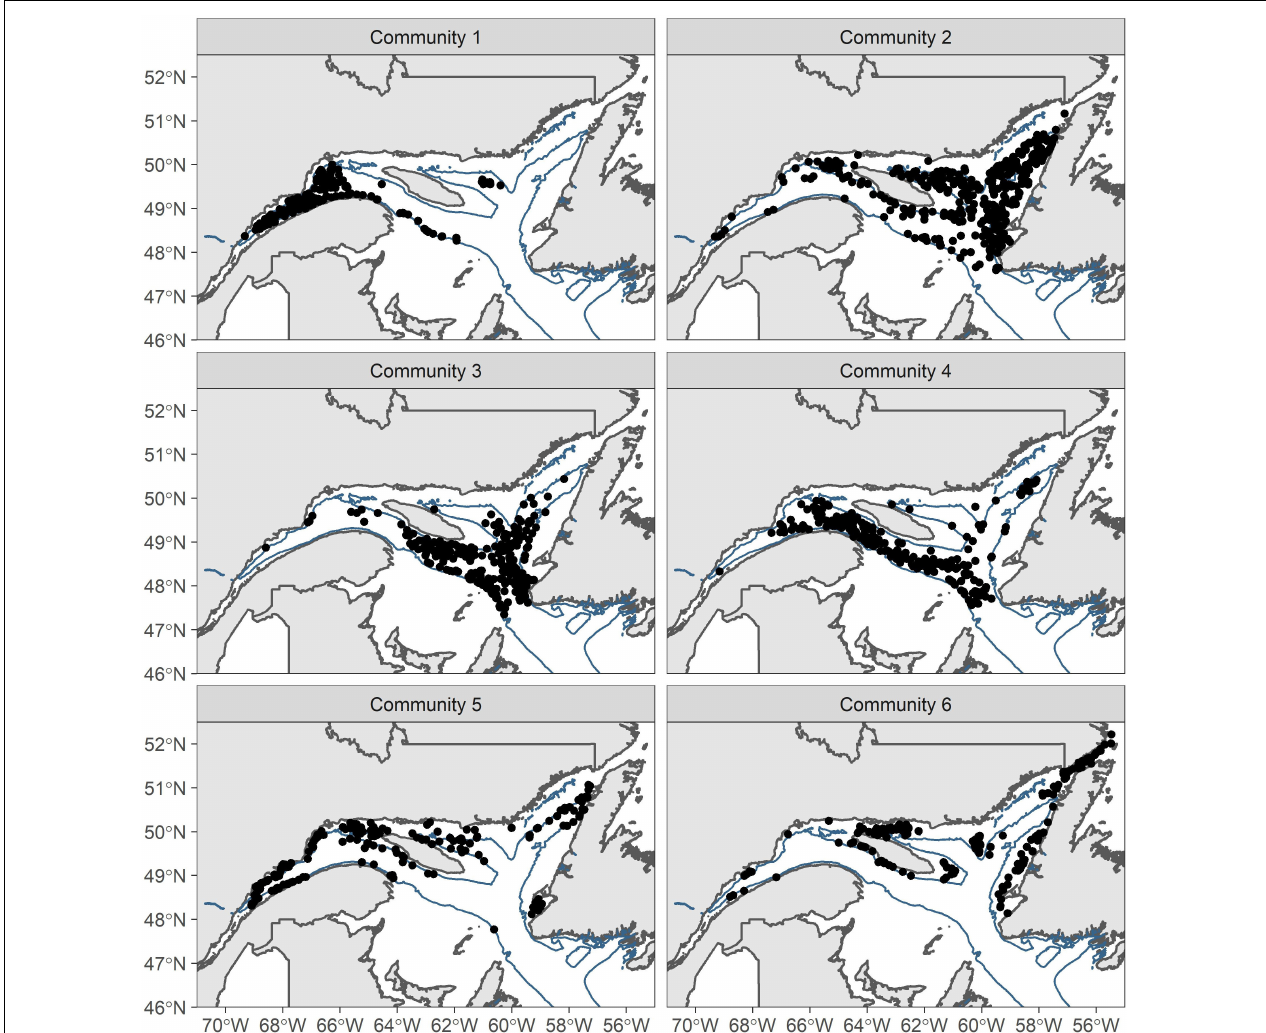
FIGURE 2 | Location of the six epibenthic community types in the Estuary and Gulf of St. Lawrence identified by hierarchical cluster analysis with biomass data collected from 2011 to 2018. Deep channels are shown in blue (depth > 200 m).